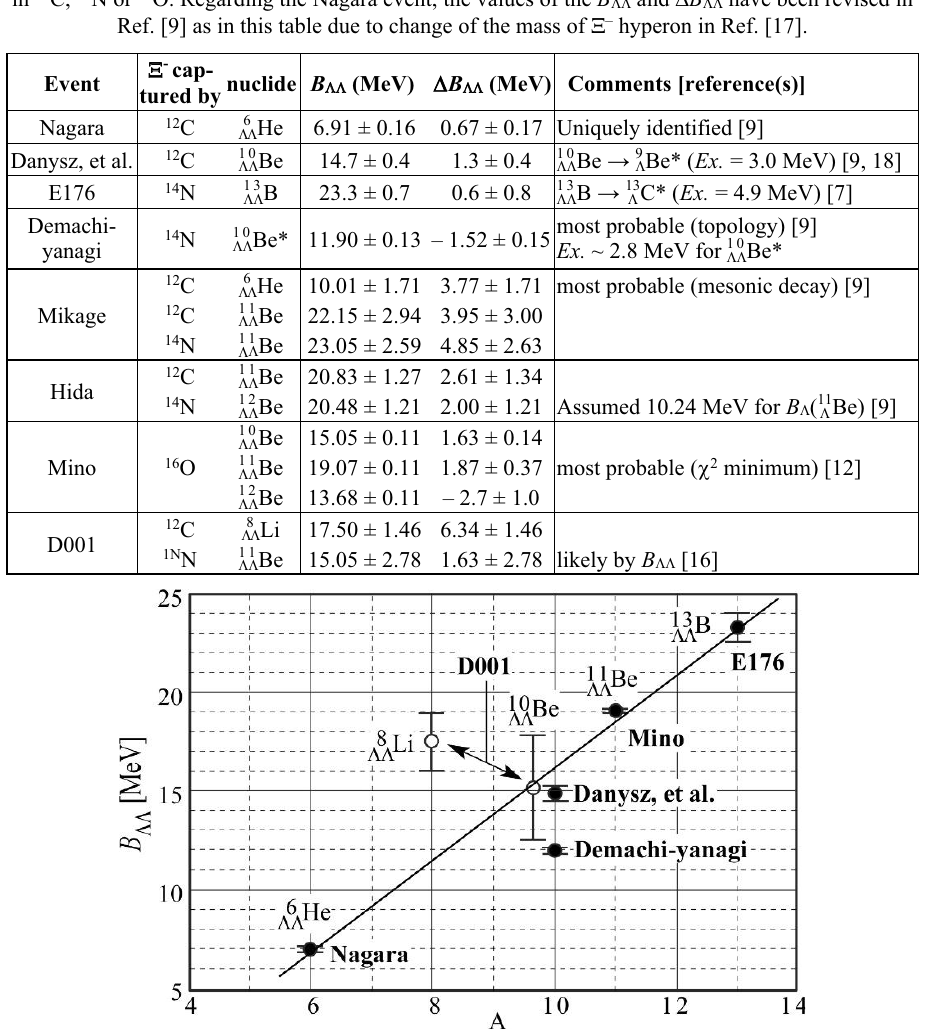
Table 1. Published data of B (cid:2)(cid:2) and (cid:4) B (cid:2)(cid:2) under assumption of (cid:3) – hyperon captured in atomic 3D state